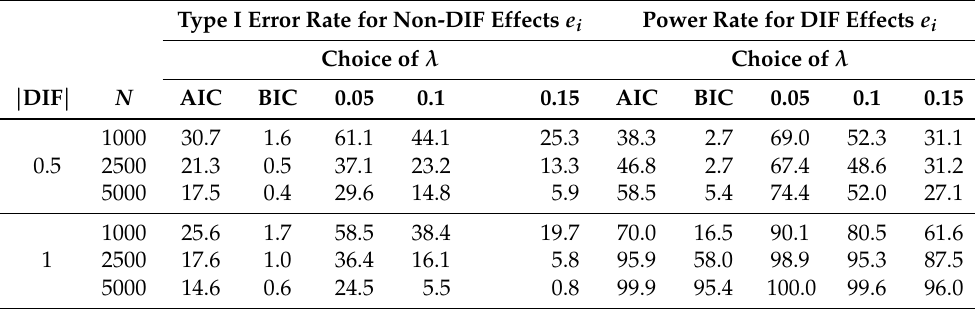
Table 2. Simulation Study 1: Average type I error rates for items with no DIF effects and average power rates for items with DIF